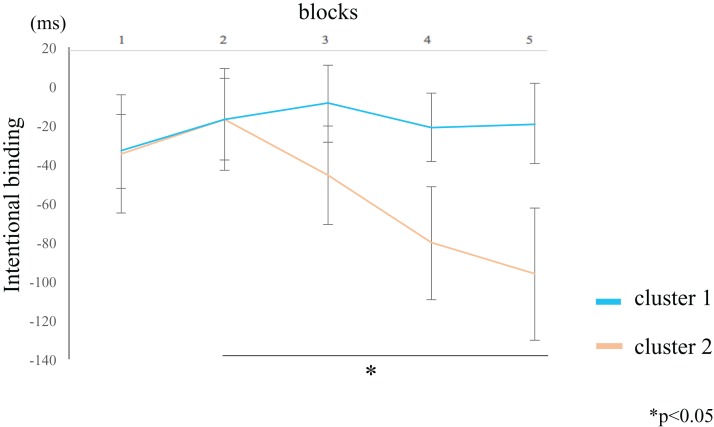
Block-wise transitions in intentional binding (IB).Within-group comparisons revealed no significant difference in the IB values between blocks for participants in cluster 1 (blue line). The IB values decreased with time for participants in cluster 2 (orange line), such that the IB value of block 5 was significantly lower than that of block 2. The data represent the means ± standard error.